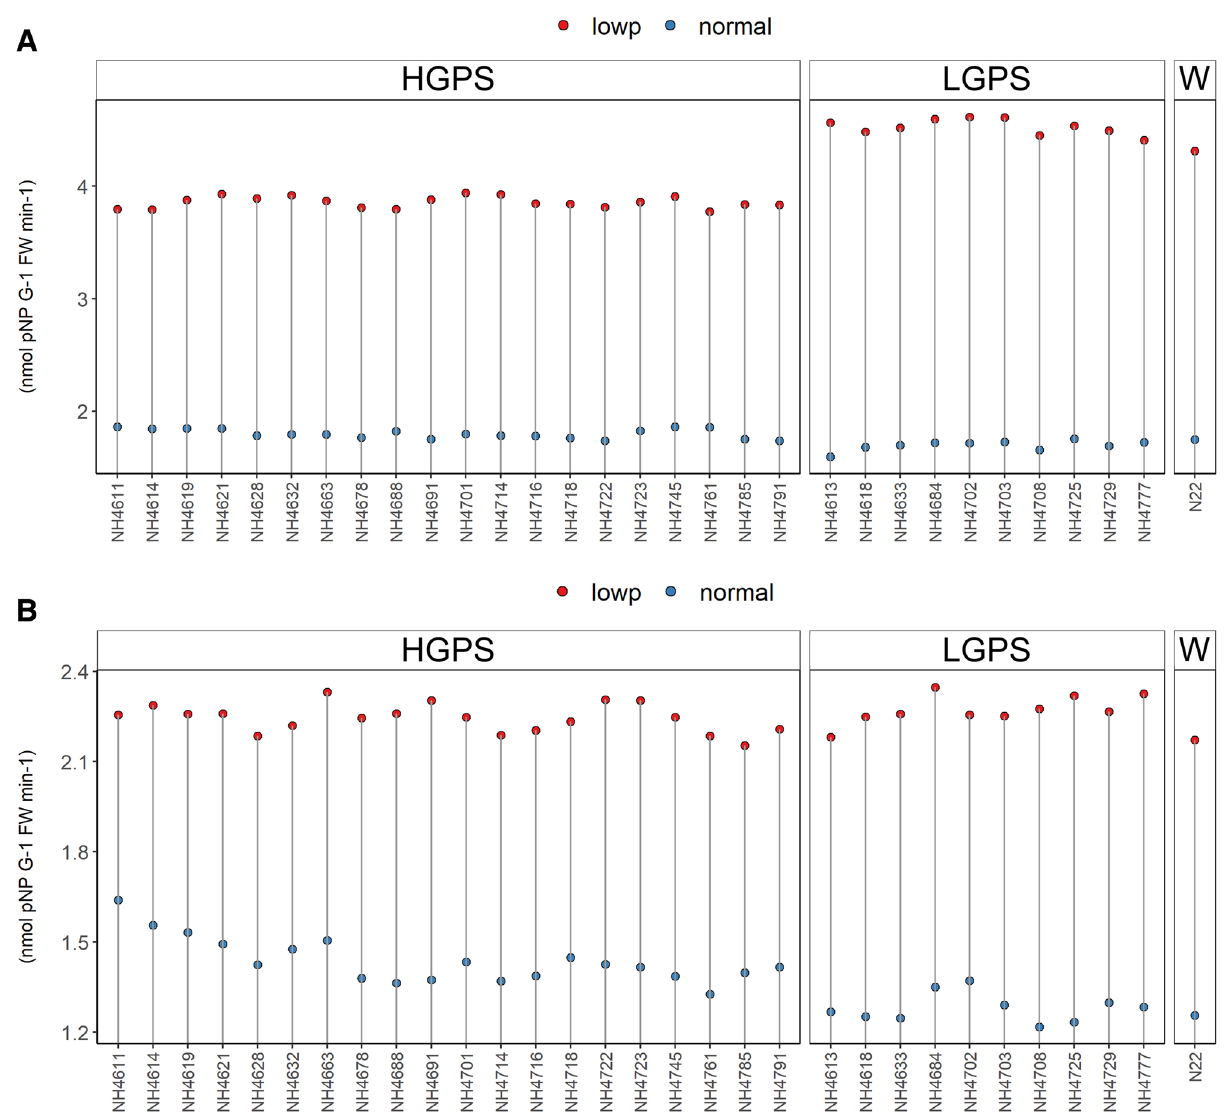
Figure 14. Shoot acid phosphatase (SApase) enzyme activity of seedlings obtained from germination of seeds harvested from low P (shown as red dots) and normal P (shown as blue dots) fields. Wild type N22 (W), high grain P mutant seedlings (HGPS), and low grain P mutant seedlings (LGPS) were grown under normal P condition. ( A ) SApase enzyme activity at 12 days of germination. ( B ) SApase enzyme activity at 24 days of germination. The values represent the mean of 6